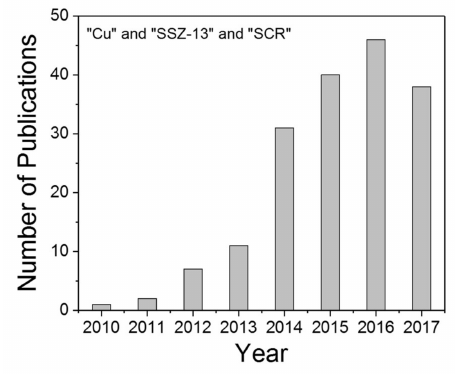
Figure 1. Number of recent publications on Cu/SSZ-13 catalysts for NH 3 Selective Catalytic Reduction